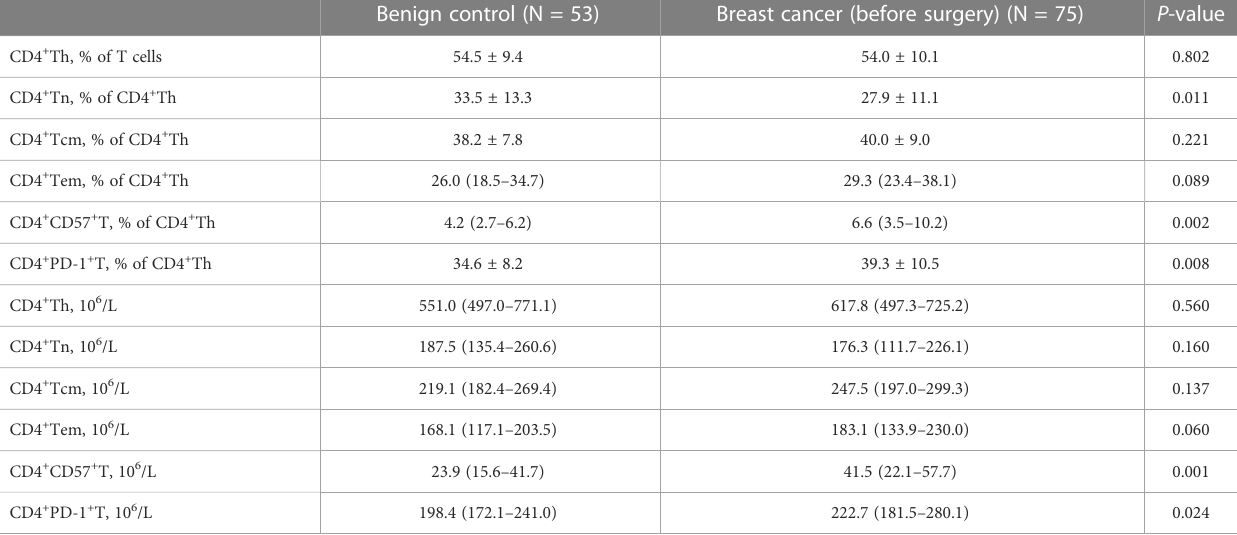
TABLE 2 Preoperative CD4 + Th subsets in the breast cancer and benign tumor groups. Benign control (N = 53) Breast cancer (before surgery) (N =